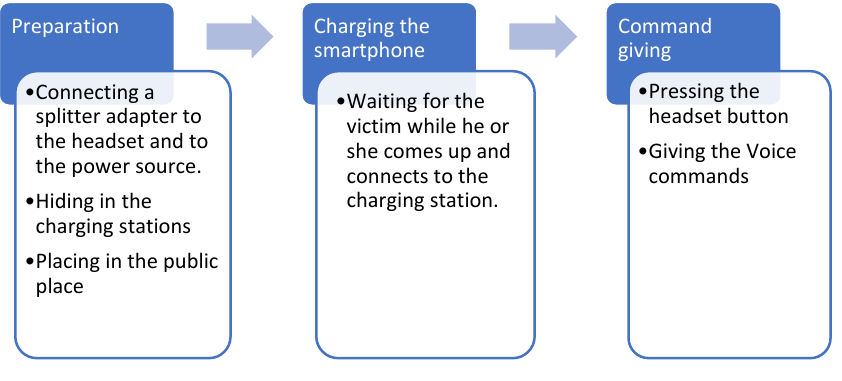
Figure 14. The attack flow.